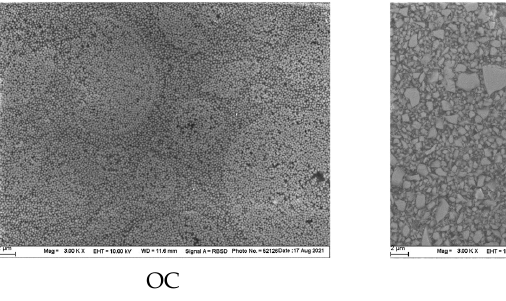
Figure 12. SEM images, electron backscatter diffraction mode. Structural appearance of the filler system in OC = Omnichroma; VDO = Venus Diamond One, and VPO = Venus Pearl One in 3000× magnifications (scale = 2 μm).